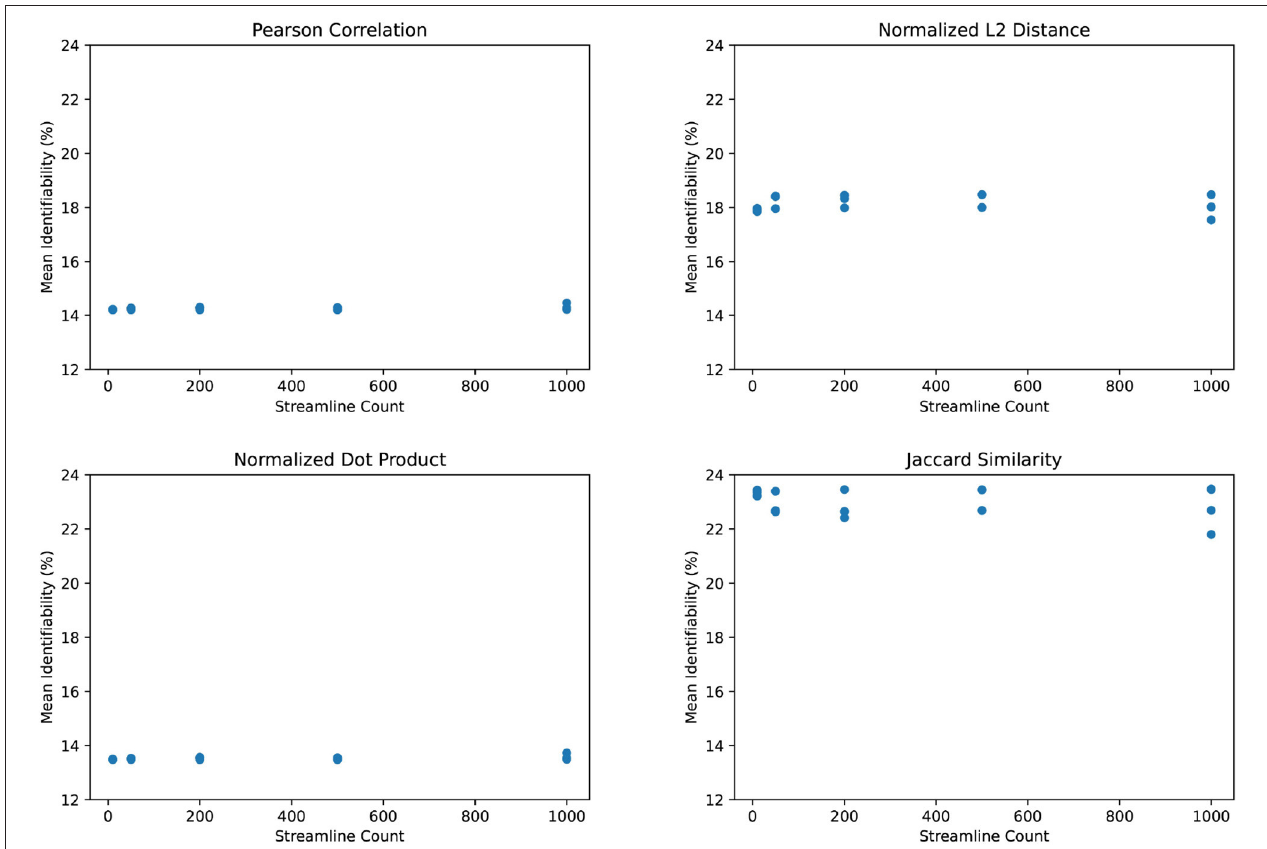
FIGURE 6 | Mean identifiability by correlation metric ( q = 4 random seeds per streamline count, k = 20 subset size, r = 10 repetitions).